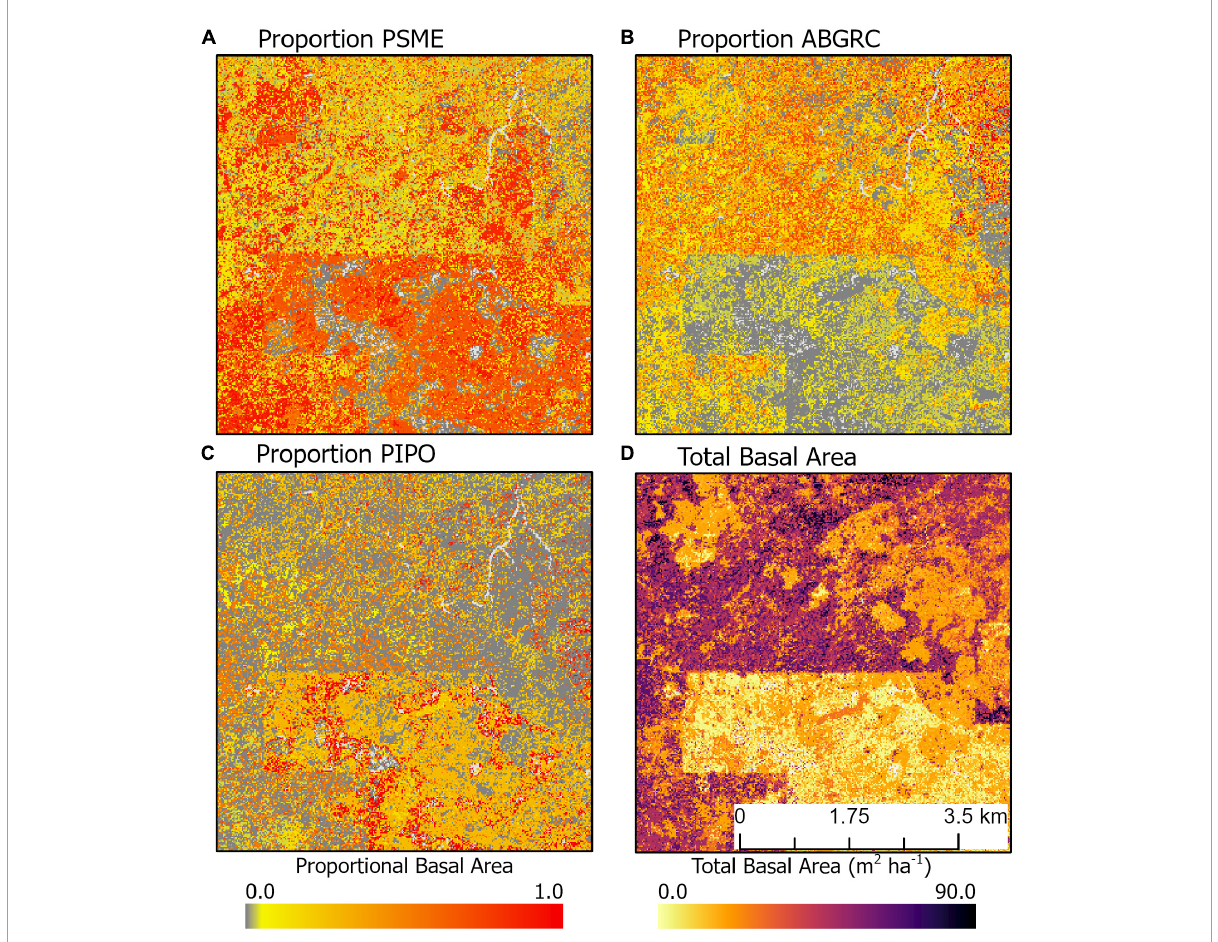
FIGURE8 Example of spatial variation in the proportional basal area of (A) P. menzeisii , (B) A. grandis and A. concolor , and (C) P. ponderosa compared to (D) total basal area. This area is northeast of Trout Lake, WA, United